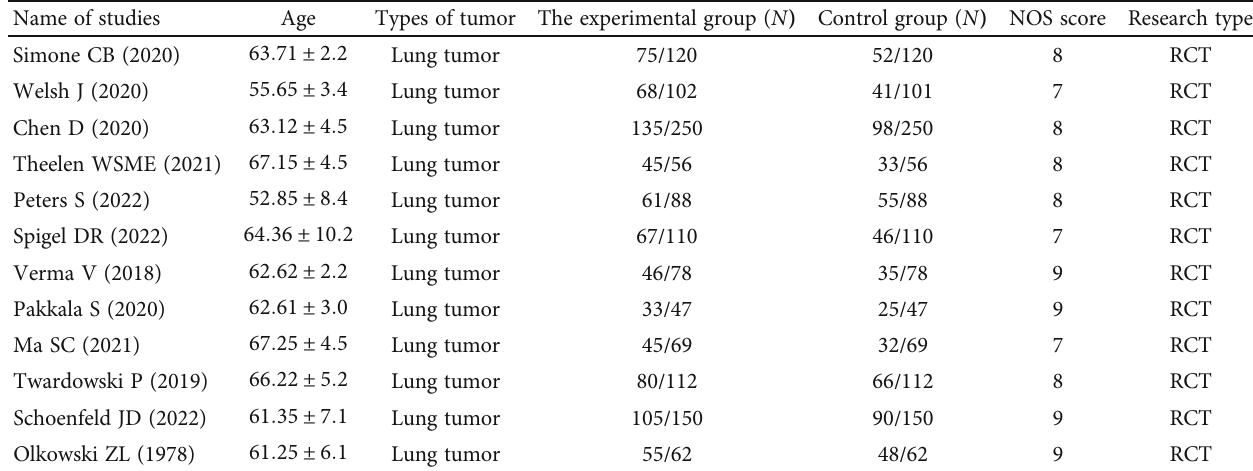
Figure 1: Selecting and arranging the literature by using multiple databases and multiple subject words and arranging it into a fl ow chart. Table 1: The basic clinical characteristics which are included in the selected 12 works of literature. Name of